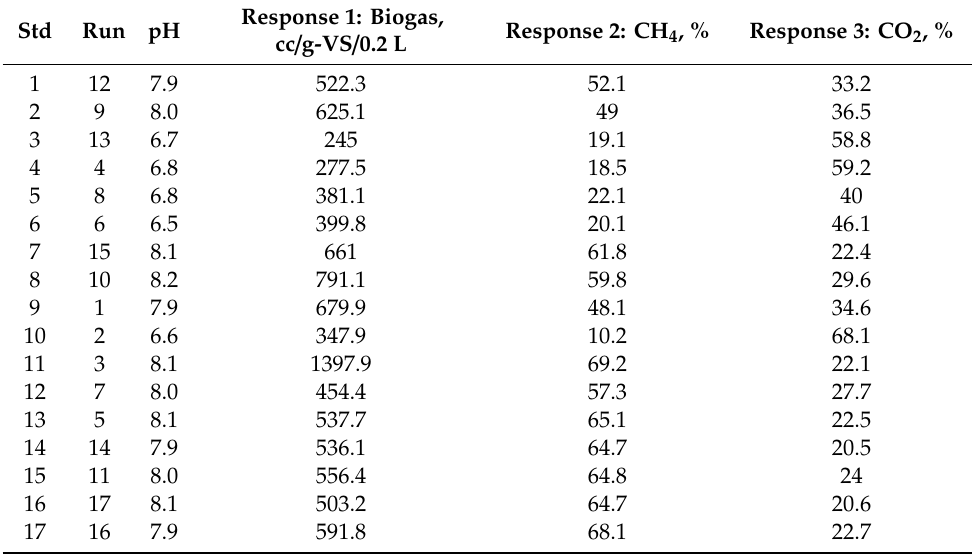
Table 4. The pH and results of the responses of the biogas produced from the samples. Std Run